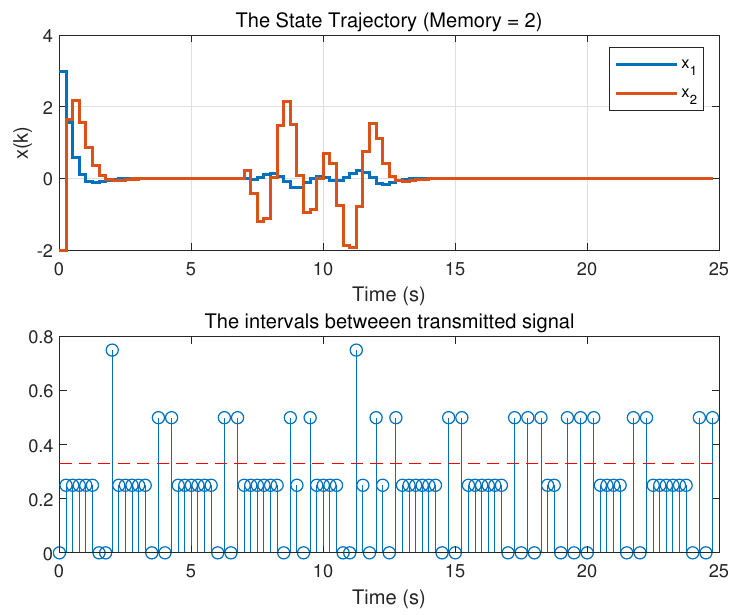
Figure 7. The state trajectories of the system for N = 3.